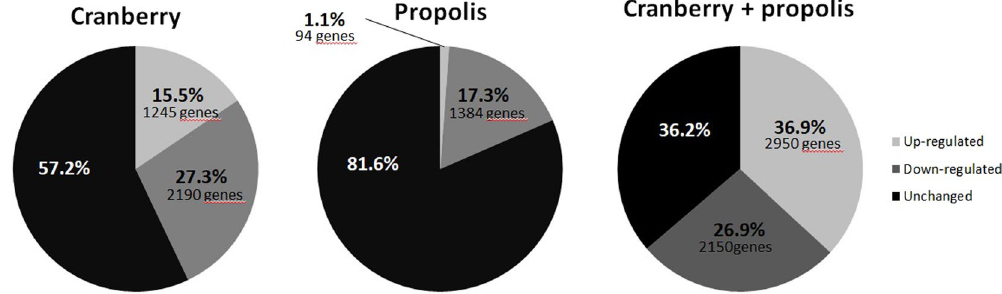
Figure 1. Microarray results. Proportion of genes up-regulated and down-regulated by cranberry (190 μ g/mL) and propolis (102.4 μ g/mL) alone and combined. Cranberry up-regulates 1,245 genes and down-regulates 2,190 genes. Propolis up-regulates 94 genes and down- regulates 1,384 genes. Cranberry + propolis up-regulate 2,950 genes and down-regulate 2,150